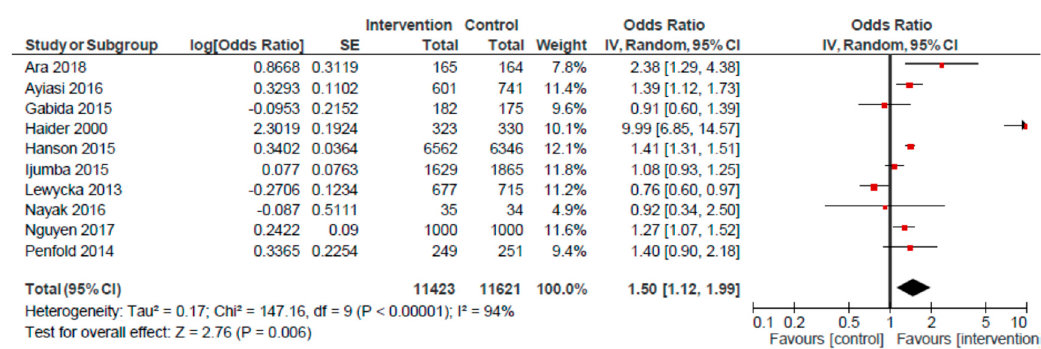
Figure 1. Forest plot of the meta-analysis of early initiation of breastfeeding for home visits (randomized studies).